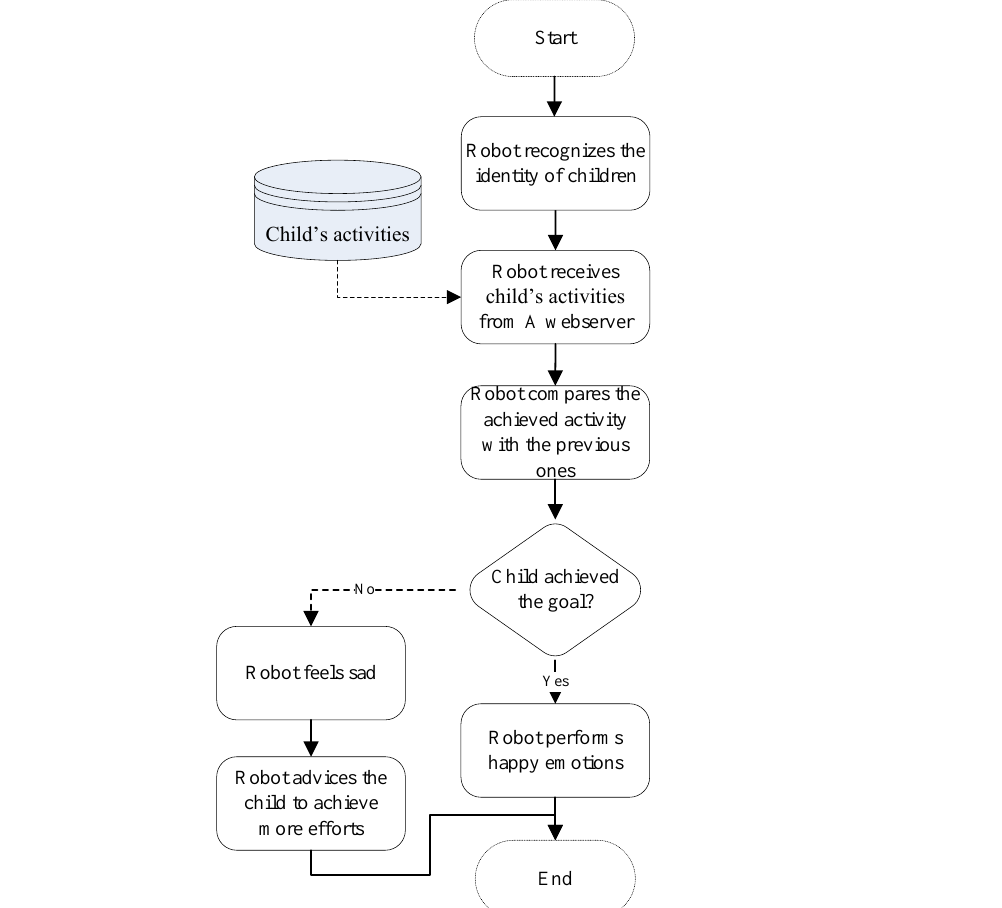
Figure 4. Flowchart for the interaction process between the obese child and NAO robot.